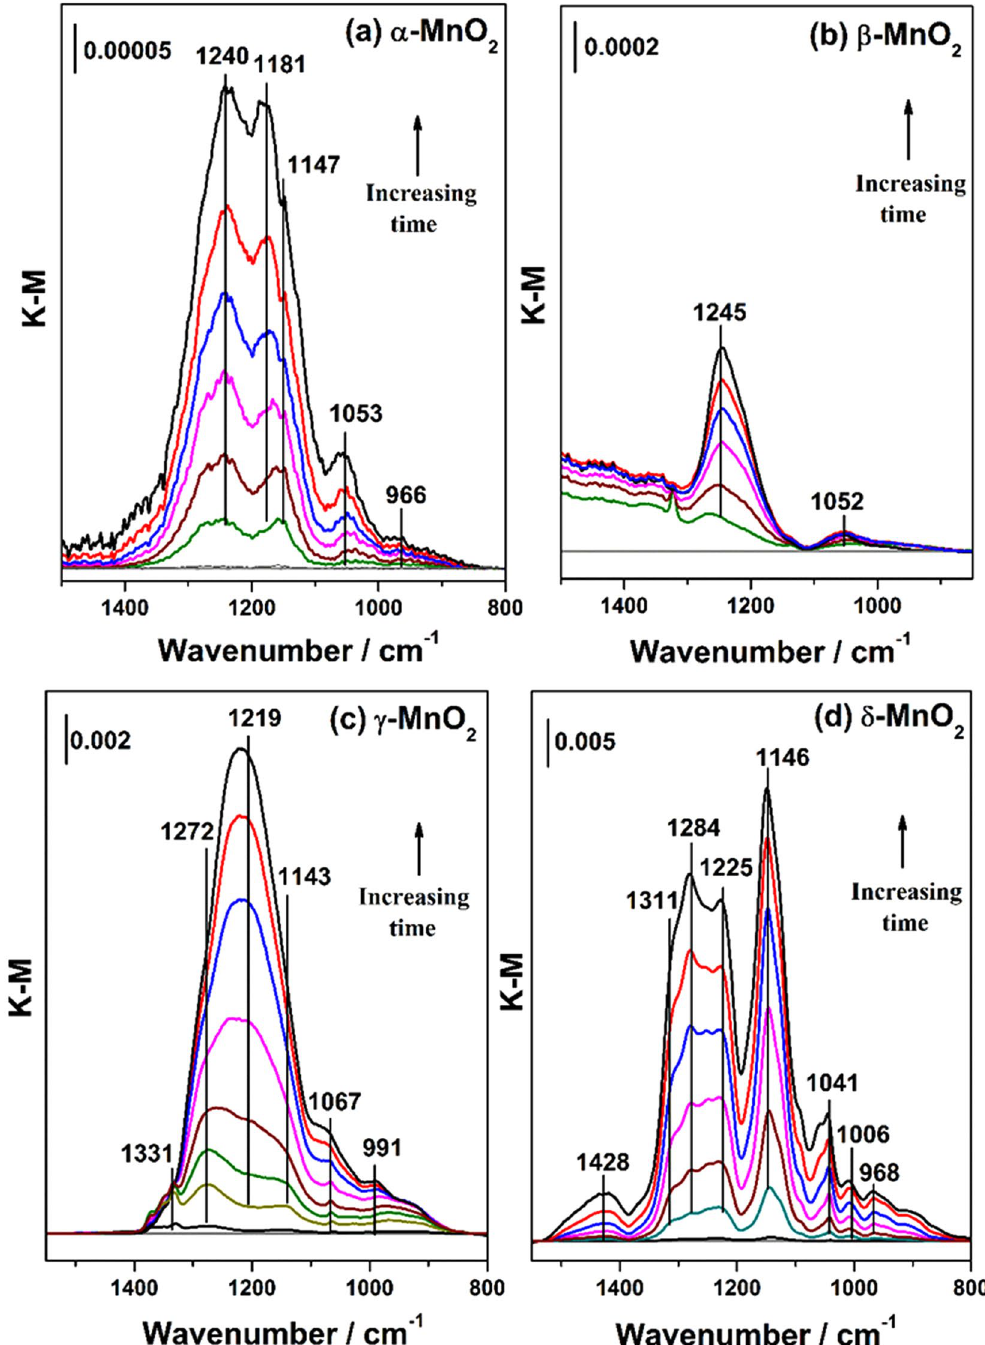
Figure 3. DRIFTS spectra recorded for the heterogeneous reactions of 40 ppmv SO 2 on ( a ) α -, ( b ) β -, ( c ) γ -, ( d ) δ -MnO 2 as a function of time under dry conditions, balanced with synthetic air in a total flow of 100 mL/min. The reaction time was 60